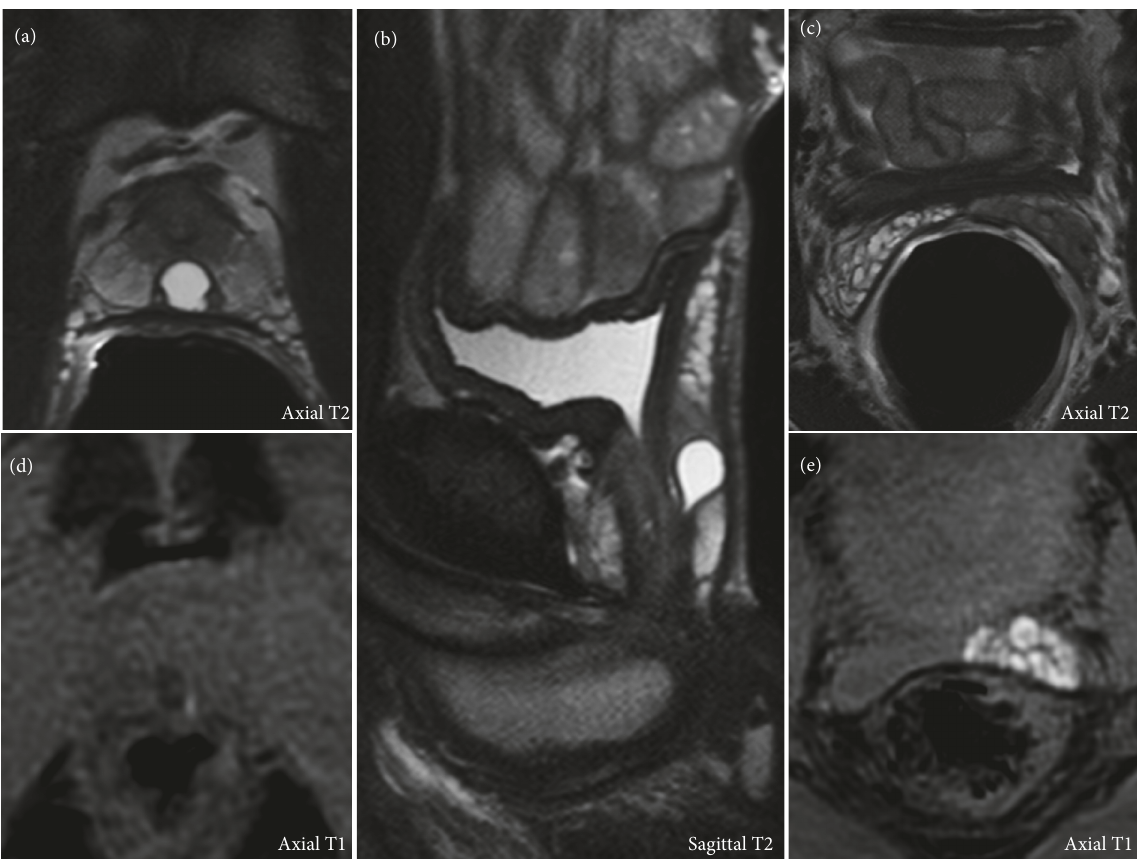
Figure 1: Summary sheet of 3-tesla MRI examination. Panels (a), (b), and (c) are acquired with an endorectal coil. Panels (d) and (e) are acquired without an endorectal coil and are the prebolus phase of the dynamic contrast-enhanced MR perfusion serving as T1-weighted images without gadolinium. Panels (a), (b), and (d) are centered on the cystic lesion. Panels (c) and (e) show stigmata of hematospermia in the left seminal vesicle. The orthogonal planes are specified in each